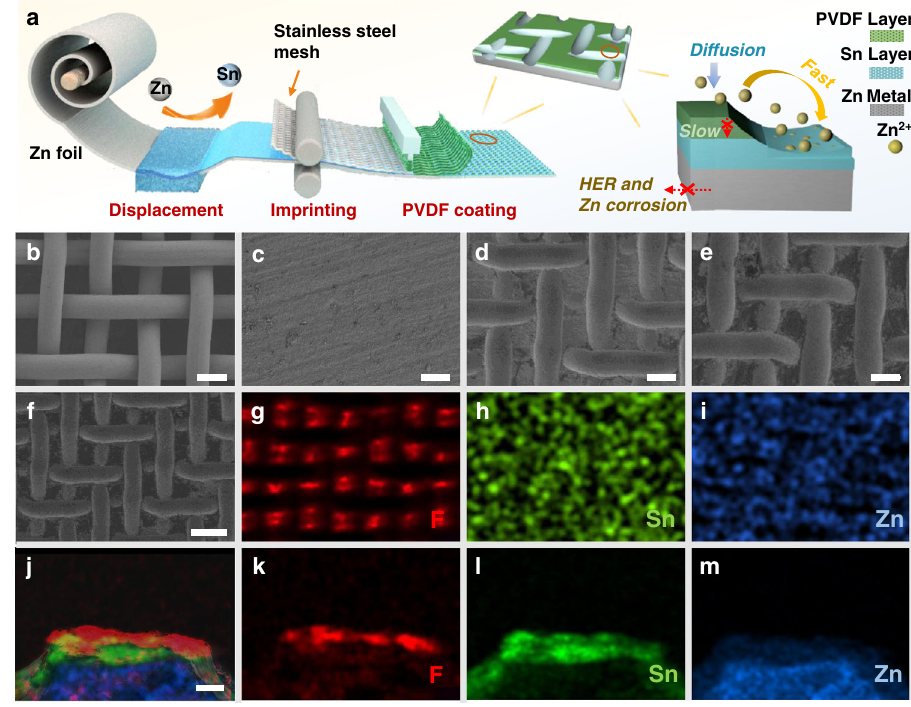
e , f PVDF-Sn@Zn gradient electrodes. g – i The corresponding EDS mappings of f . j – m Cross-sectional SEM and the corresponding EDS mapping of PVDF-Sn@Zn gradient electrode. Scale bar, 30 μ m for b – e , 60 μ m for f - i , and 5 μ m for j – m